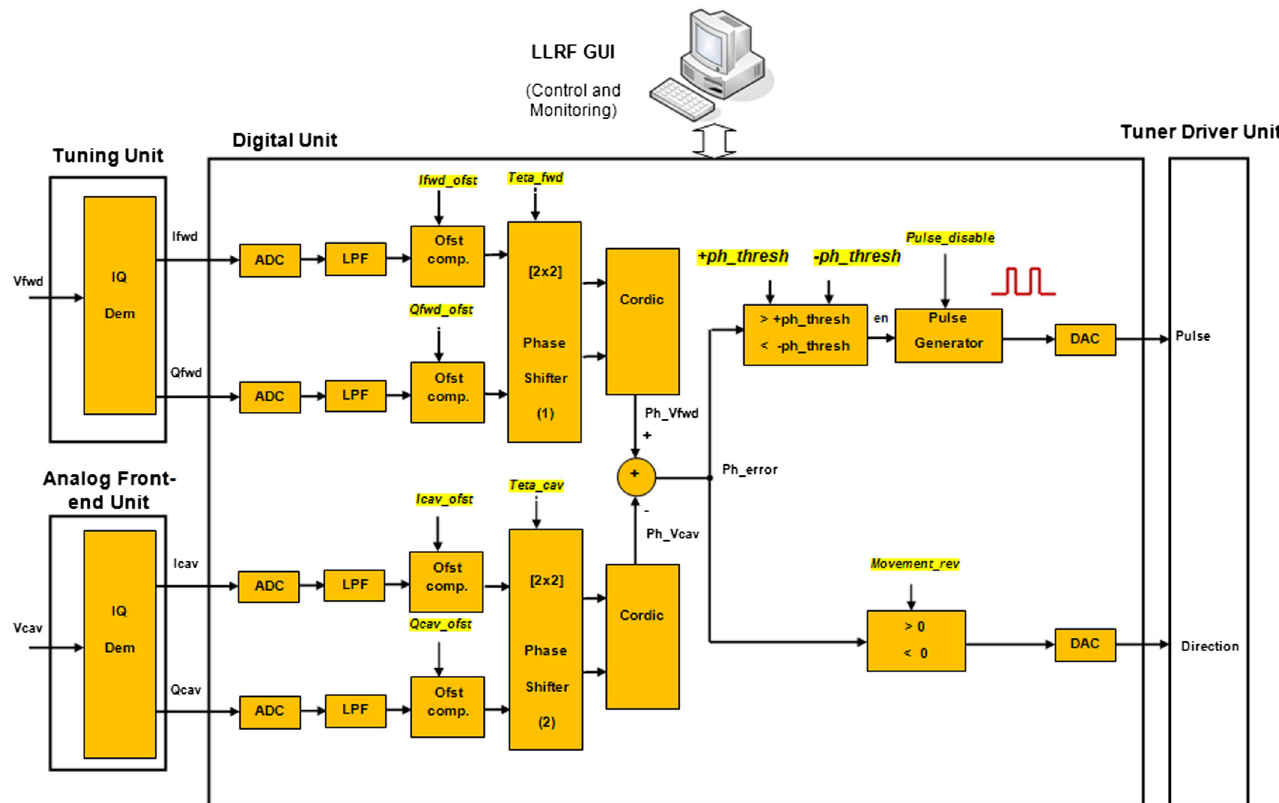
FIG. 8. Simplified block diagram of the FPGA program for cavity tuning; the parameters marked as italic are set from the control